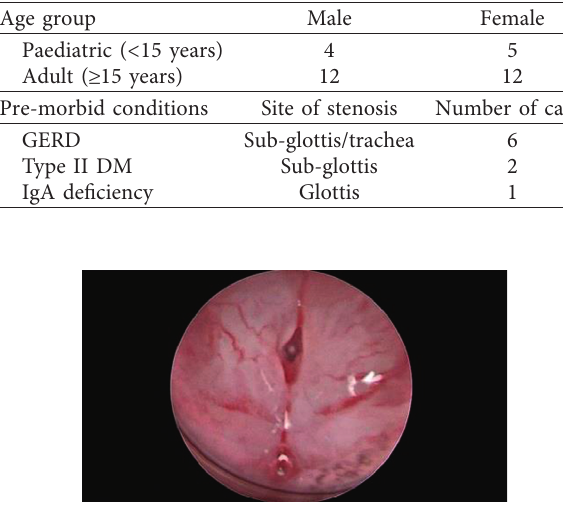
Table 1: Age group and gender distribution among the cases with identified comorbid conditions.